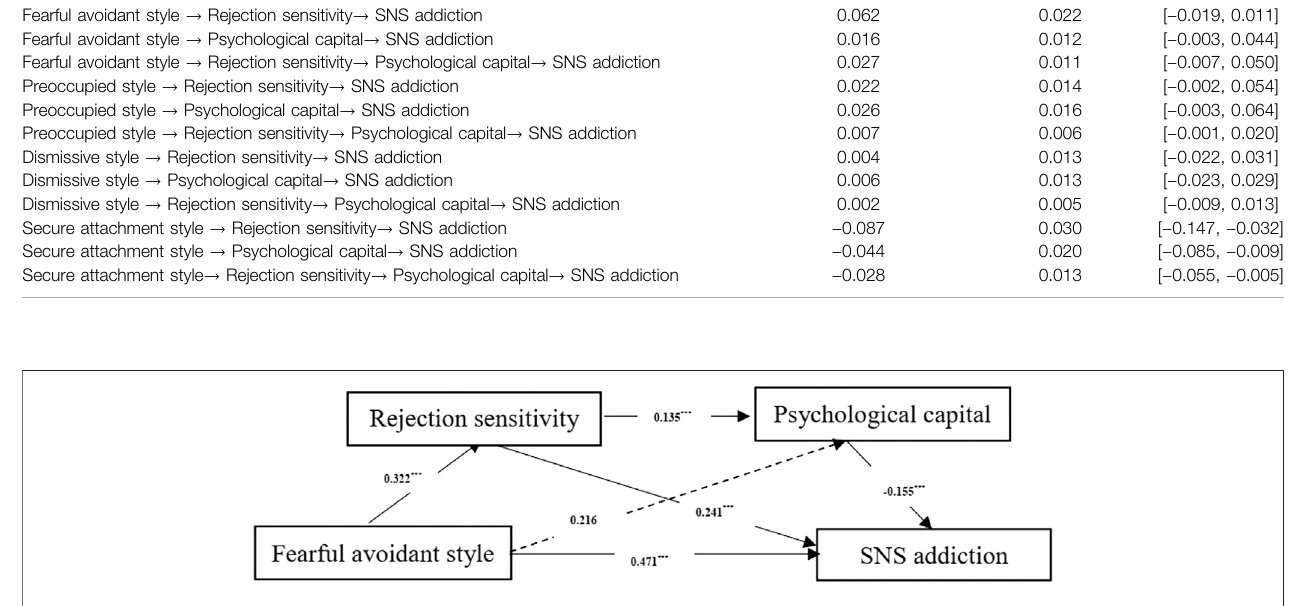
FIGURE 3 | The unstandardized coef fi cients of the